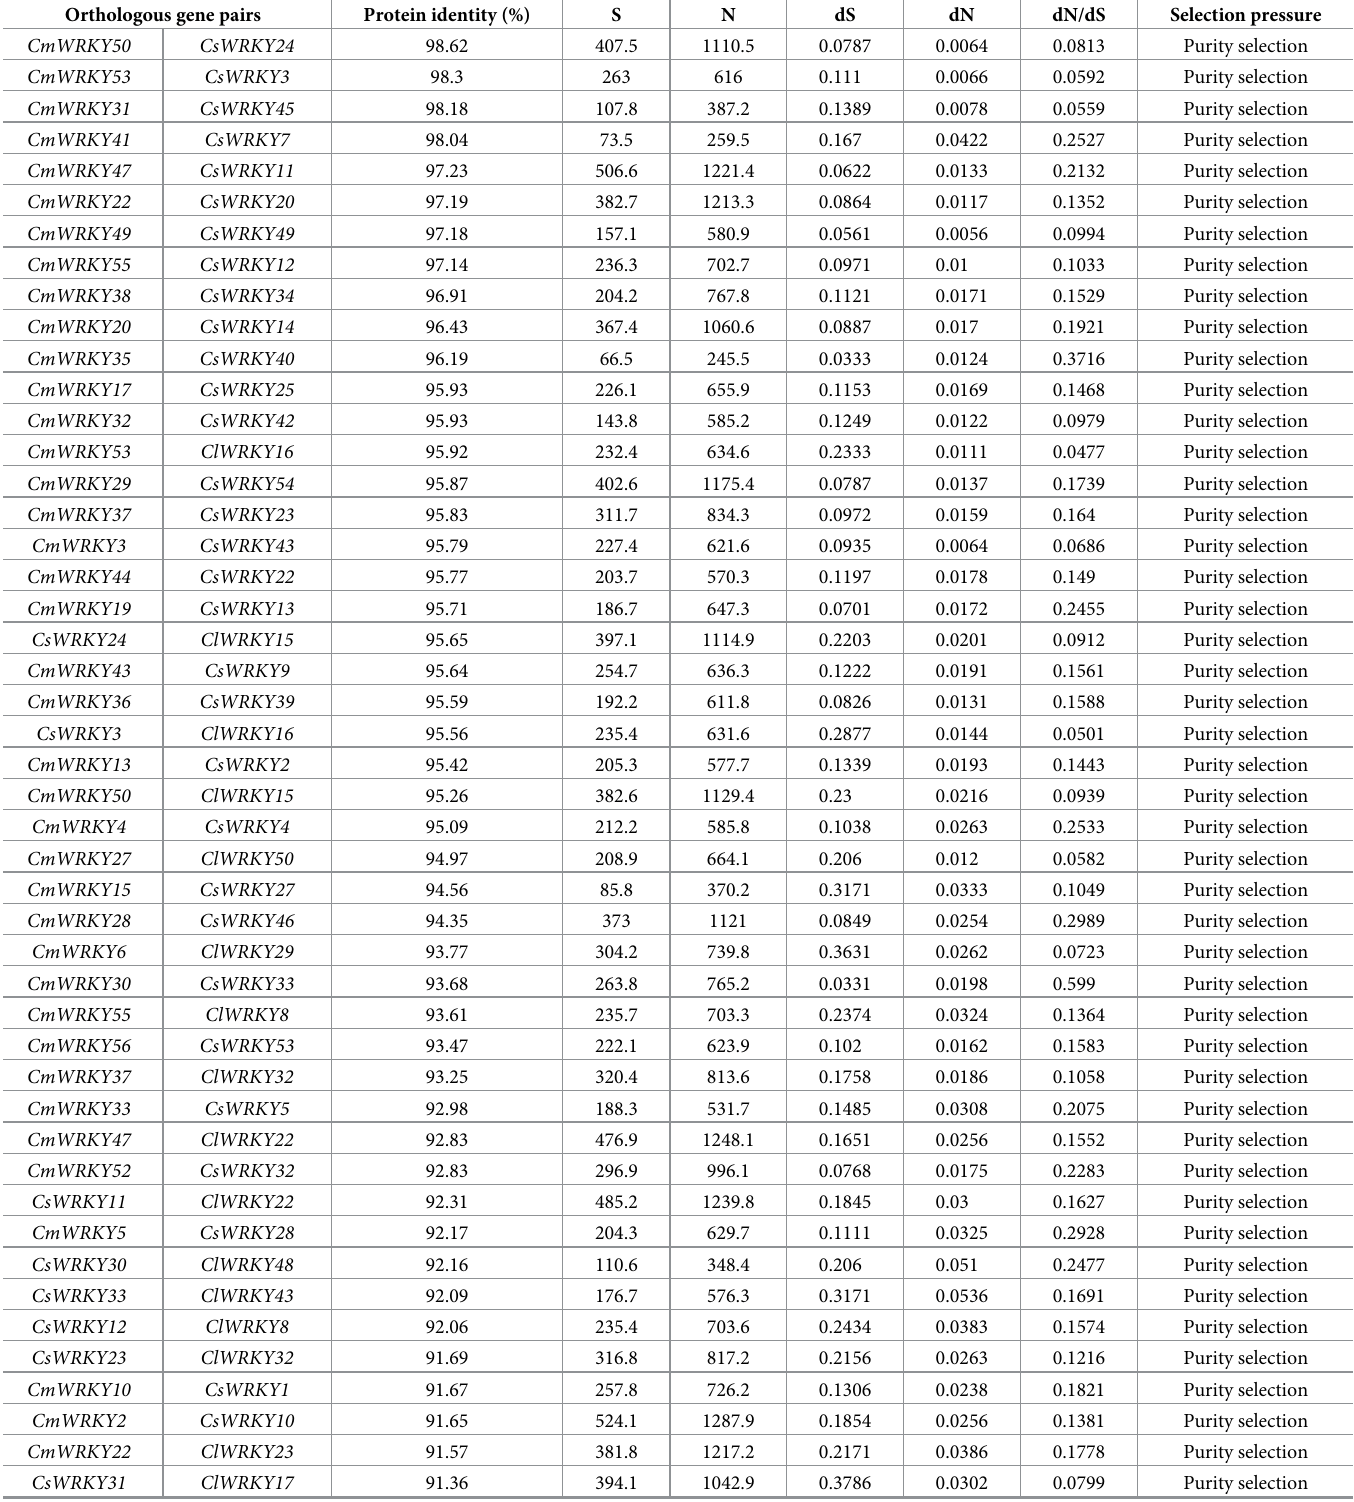
Table 1. Ka/Ks calculation of each orthologous pairs among three cucurbitaceae species. Orthologous gene